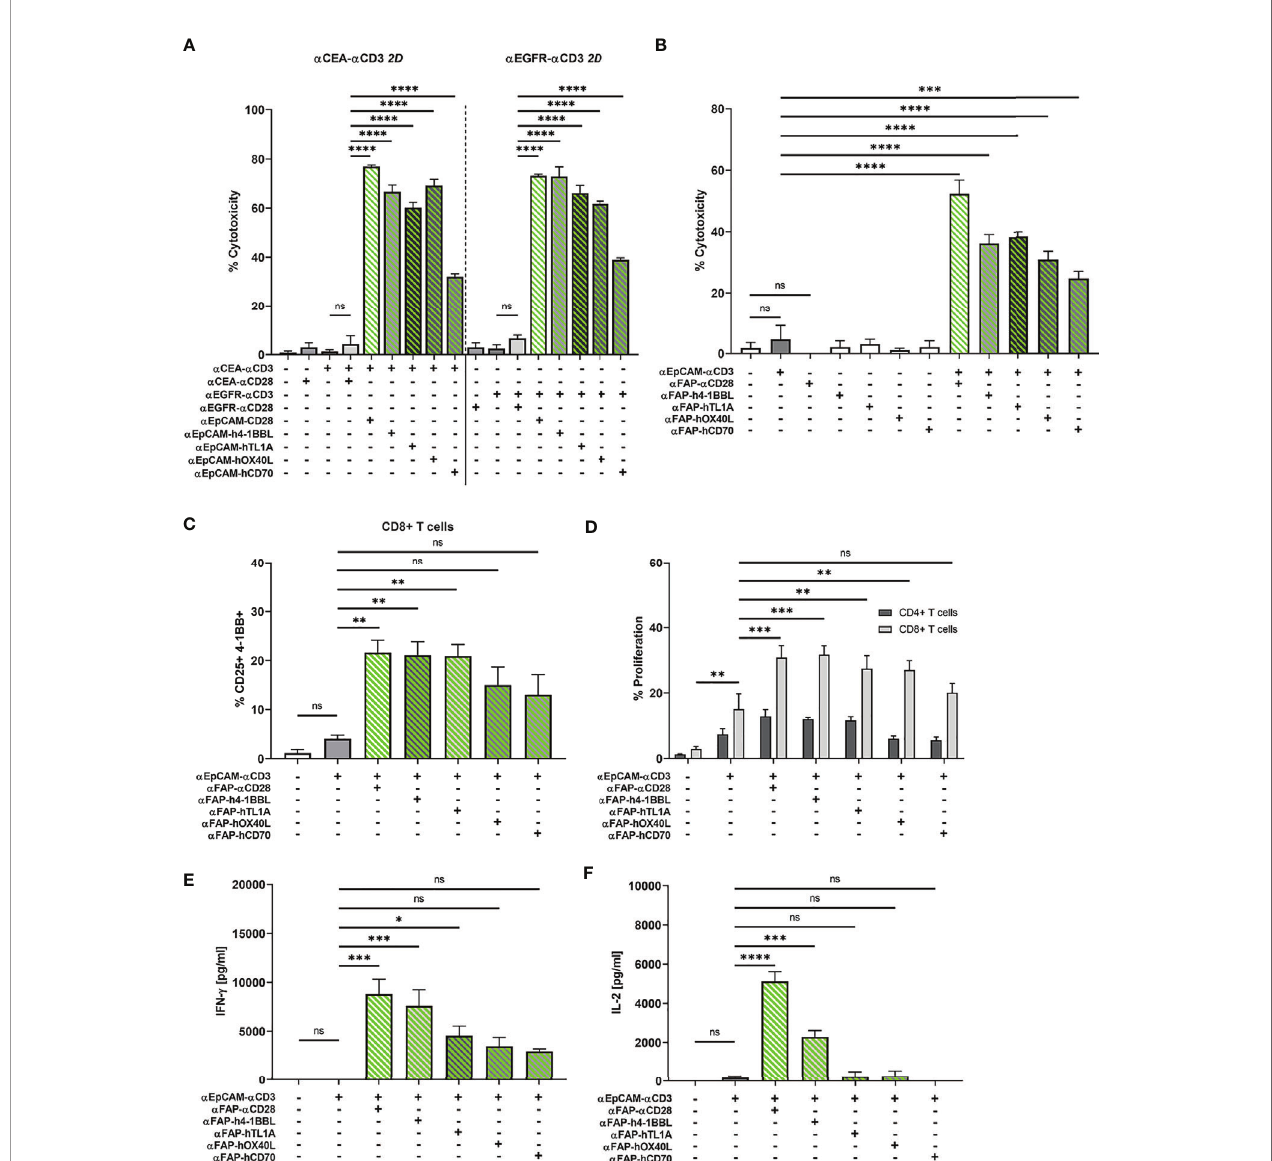
FIGURE 5 | (A) Split co-stimulation with a EpCAM – TNFL fusion proteins in the 2D adherent cell model. a CEA – a CD3 (1 nM, left) or a EGFR – a CD3 BiMAb (1 nM, right) were used in cytoxicity assays (LDH release) with MCF-7 target cells (E:T ratio 2:1) +/- the indicated a EpCAM – TNFL fusion proteins (1 nM) or a CEA/ EGFR – a CD28 BiMAb (1 nM) that were used for statistical comparison by one-way ANOVA with Dunnett ’ s follow-up test. (B – F) Bifunctional a TAA scFv – TNFL fusion proteins provide co-stimulation to a CD3 BiMAb-activated T cells in a split co-stimulation approach in the 3D spheroid model. Tumor spheroids containing MCF-7 + HT-1080/FAP cells in a 1:1 ratio were co-cultured with puri fi ed unstimulated T cells and combinations of a EpCAM – a CD3 BiMAb +/- 10 nM a FAP – a CD28 BiMAb or 10 nM fusion proteins of a FAP scFv-hIgG-Fc and ectodomains of tumor necrosis factor superfamily ligands (TNFL) 4-1BBL, CD70, OX40L or TL1A. (B) Cytotoxicity based on LDH release, measured in supernatants collected after 48h of co-culture. (C) Frequencies of CD25 and 4-1BB double positive CD8 + T cells analyzed by fl ow cytometry. (D) Proliferation of CTV-labelled CD4 + and CD8 + T cells measured by fl ow cytometry after 5 days of co-culture. Proliferation of CD4 + T cells was not signi fi cantly enhanced. Cytokine release (in pg/ml) of IFN- g (E) and IL-2 (F) was measured after 48 h of co-culture by ELISA. Data represent the mean ± SEM from 3 independent experiments in duplicates. Statistical analysis vs . a EpCAM- a CD3 groups by one-way ANOVA (B, C, E, F) or two-way ANOVA (D) , both with Dunnett ’ s follow-up test; ns, not signi fi cant; * p < 0.05; ** p < 0.01; *** p < 0.001; **** p <